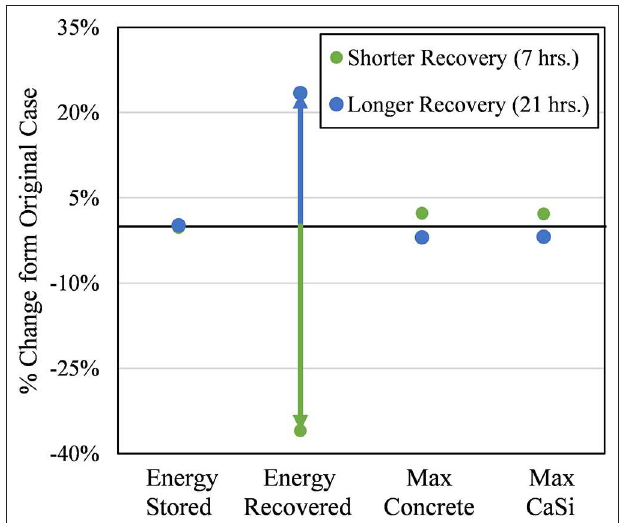
FIGURE 11 | Sensitivity of key results to a 50% longer (to 21h) and shorter (to 7h) from the original recovery length (14h). Energy stored refers to the quantity of thermal energy remaining in the particles at the end of the last storage cycle. Energy recovered refers to the quantity of thermal energy recovered by the particles at the end of the last recovery cycle. Max. Concrete and CaSi refer to the absolute maximum point temperature over the final cycle for the respective